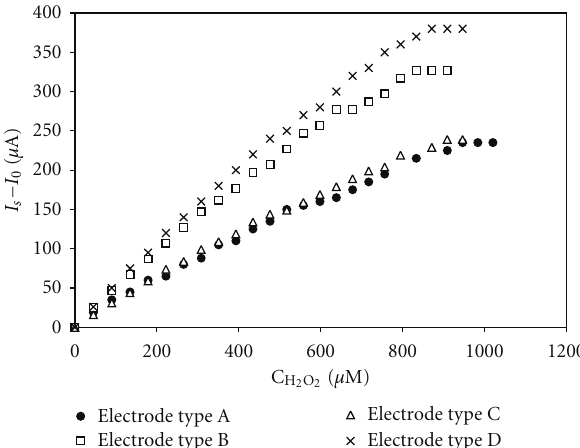
Figure 2: Background subtracted steady-state response of the elec- trode type B (Pd to Au in atomic ratio 90%:10% on glassy carbon) as a function of hydrogen peroxide concentration at an applied potential of − 100 mV (Ag/AgCl, 1 MKCl); phosphate-citrate bu ff er, pH 7.0; temperature 25 ◦